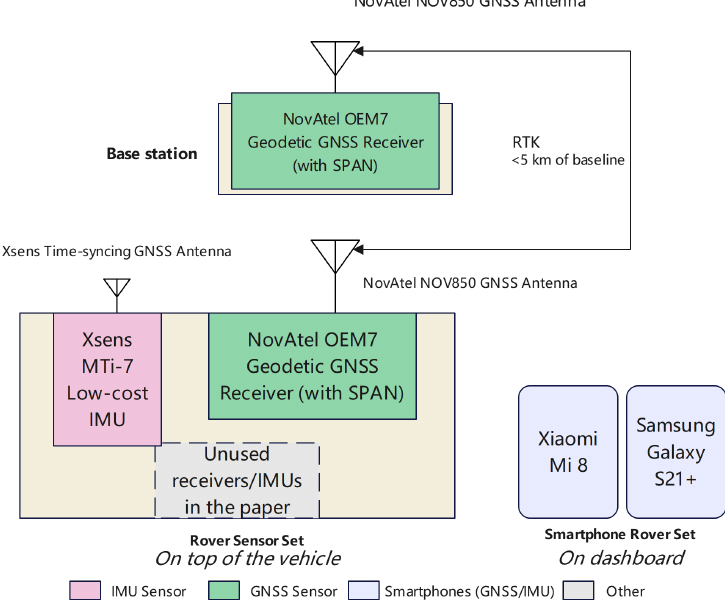
Figure 2. Schematic of equipment setup for measurement Campaigns.